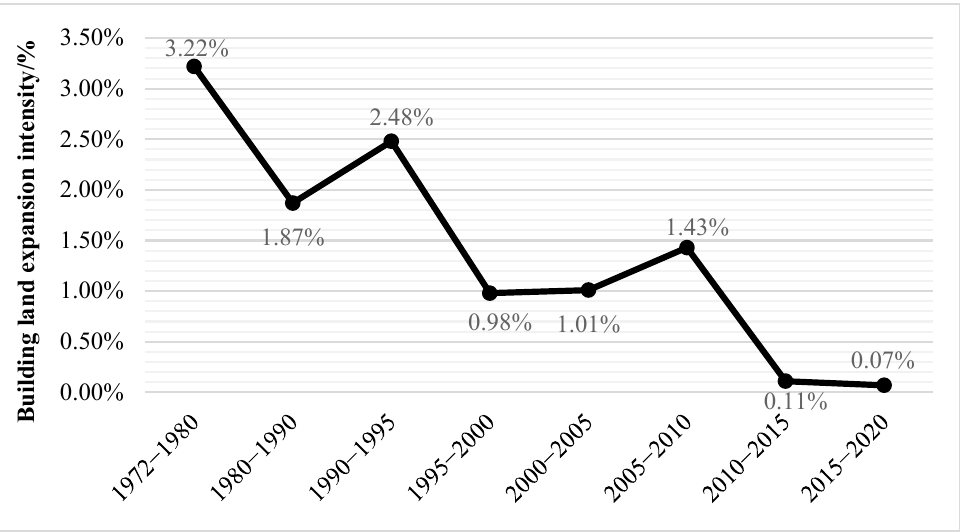
Figure 4. Line chart of expansion intensity of construction land in Hong Kong. Table 3. Statistical table of reclamation projects in Hong Kong, 1980–1990 (incomplete statistics).